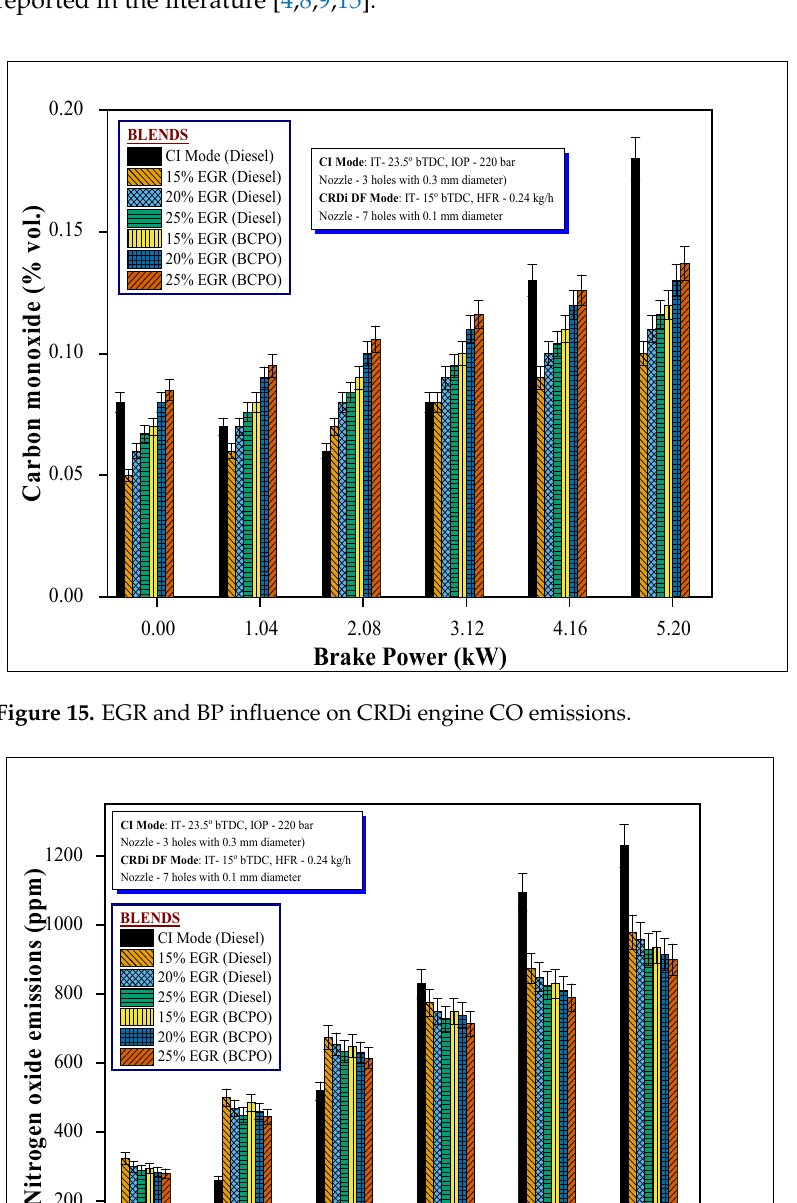
Figure 14. EGR and BP influence on CRDi engine HC emissions.